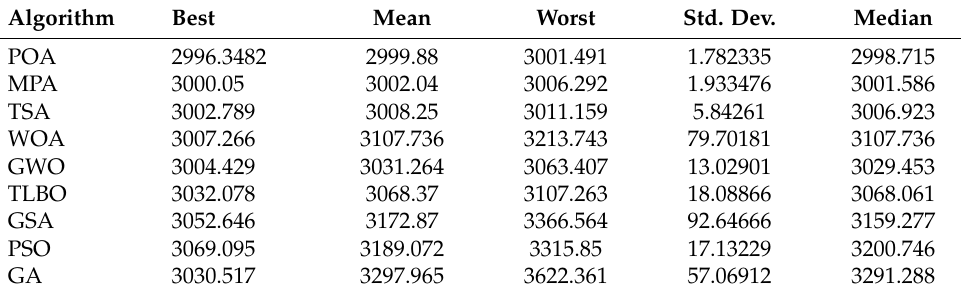
Table 12. Statistical results for speed reducer design